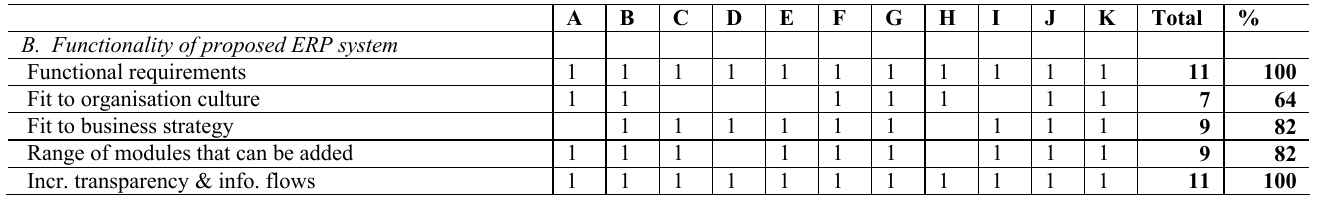
Table 4: Summary of functionality selection criteria considered